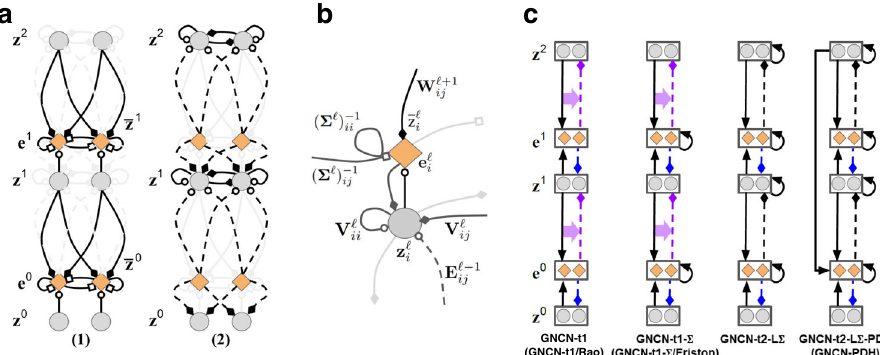
; z 2 ; z 1 ; z 0 (cid:7)Þ T , z 1 ¼ ð½ z 1 (cid:7)Þ T , z 0 ¼ ð½ z 0 (cid:7)Þ T , that are updated iteratively over T time steps. 0 1 0 1 1 0 ; e 1 ; e 0 (cid:7)Þ T , e 0 ¼ ð½ e 0 (cid:7)Þ T , which compute mismatch messages that are 0 1 1 0